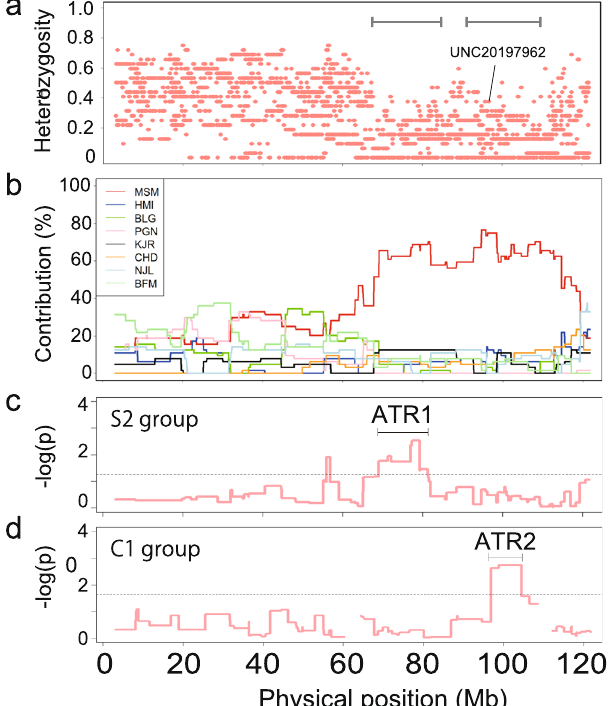
Figure 5. The haplotype derived from the MSM strain was selected in group S2 in generation G 12 . ( a ) Heterozygosity determined using overall genotyped single nucleotide polymorphism (SNP). A solid line indicates the SNP (UNC20197962) exceeded the threshold value for the MSM strain. The solid horizontal line indicates the region showing decrease of the heterozygosity. ( b ) Contributions of inferred haplotypes from the eight founder strains. ( c ) Results of linear mixed model association analysis of contacting and the inferred MSM haplotype using group S2. ( d ) Results of Cox mixed model association analysis for group